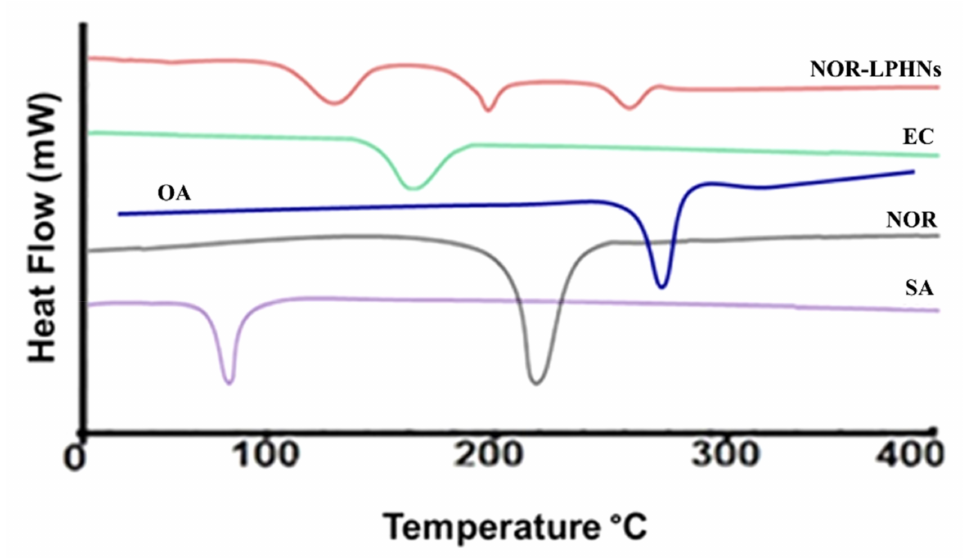
Figure 6. DSC thermogram of norfloxacin (NOR), ethyl cellulose (EC), stearic acid (SA), oleic acid (OA) and NOR-5-LPHNs.